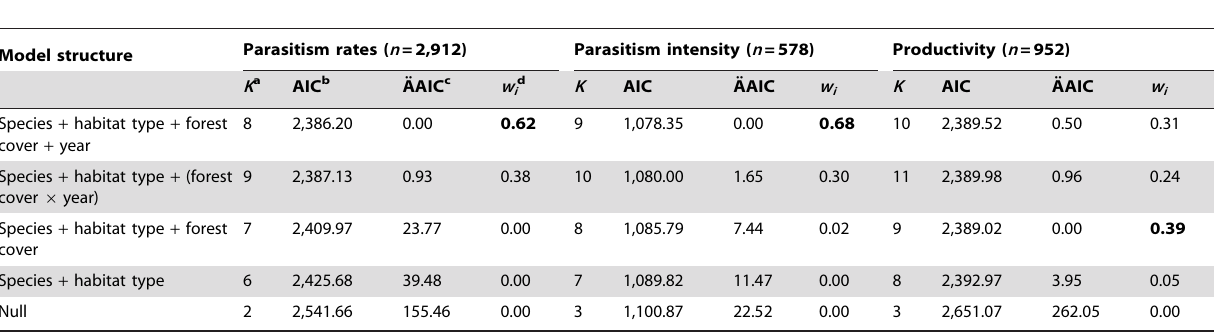
Table 1. Model selection results from analysis of temporal trends of brood parasitism and productivity (top-ranked models have weights in bold) for Indigo Buntings, Acadian Flycatchers, and Northern Cardinals in Missouri, USA, 1991–2010.